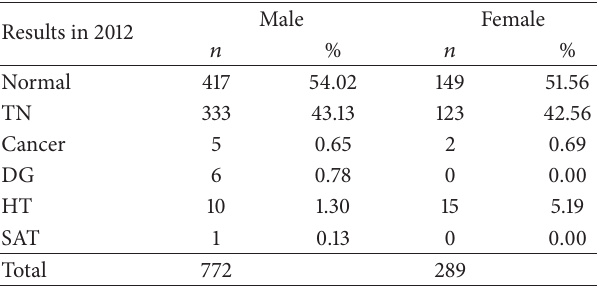
772 289 HOMA-IR All of the results were based on B-mode ultrasound scanning. Insulin 1.012 TN: thyroid nodule; DG: diffuse goiter; SAT: subacute thyroiditis; HT: Hashimoto’s thyroiditis. All of the metabolic components in 2009 were transferred into qualitative data according to the IDF criteria; MetS was defined according to the IDF criteria as well. All independent variables were adjusted by age and sex. Hypertension lost statistical significance ( 𝑃 = 0.093 ) in multivariate binary logistic regression analysis when hypertension and WC were taken as independent variables.